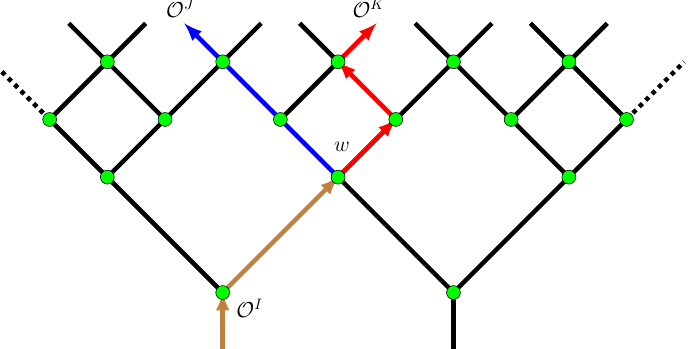
Figure 5. \Non-linear" contributions to operator pushing. The bulk operator O I splits into O J and O K . They are subsequently propagated to 1 (blue) and 2 (red)